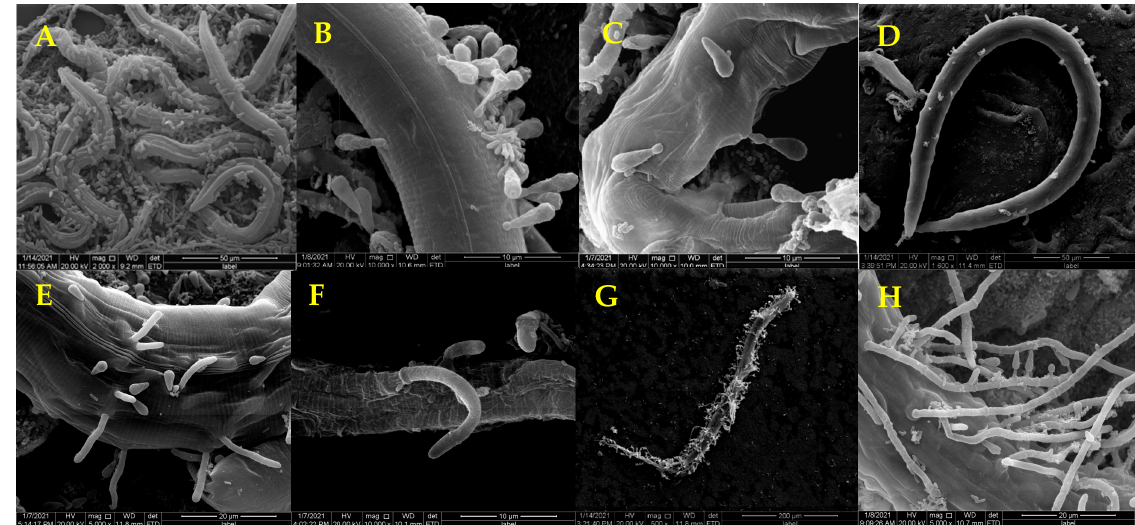
Figure 3. Infection Process of C. elegans by Spores of D. coniospora YMF1.01759.